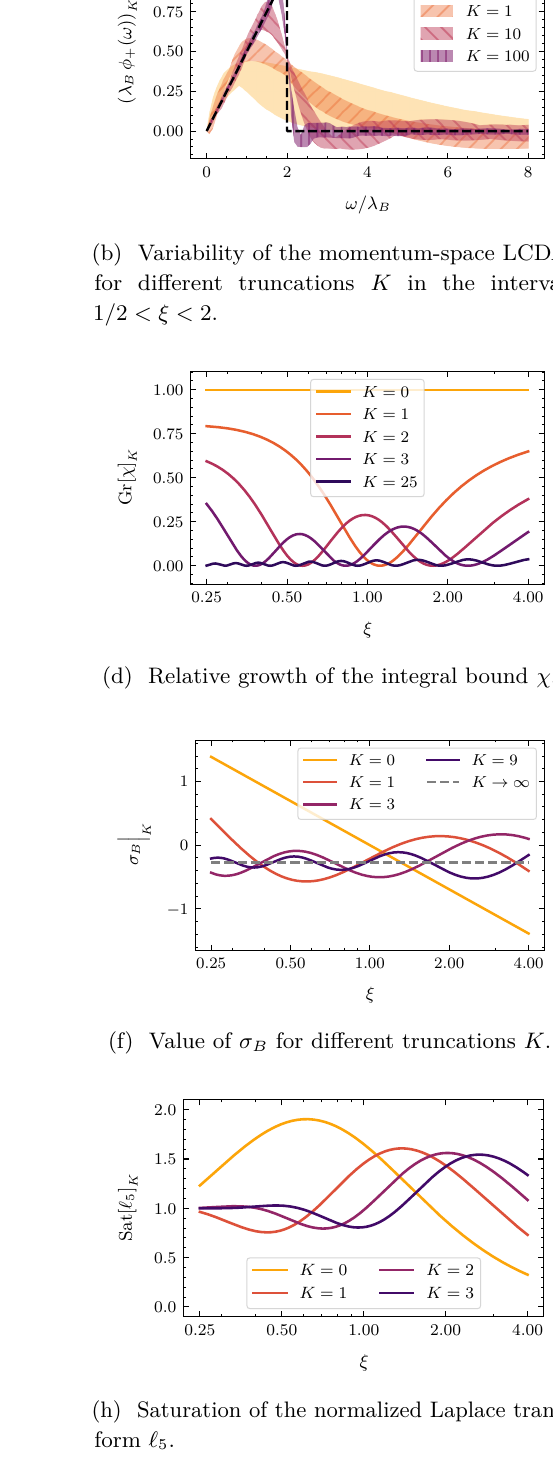
Figure 4 . Plots illustrating the truncation effects of our parametrization for the parton model eq. (4.18). We often use the ratio ξ = ω , plotted on a logarithmic 0 /λ B